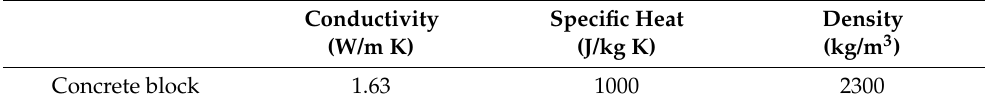
Table 4. Properties of thermal storage